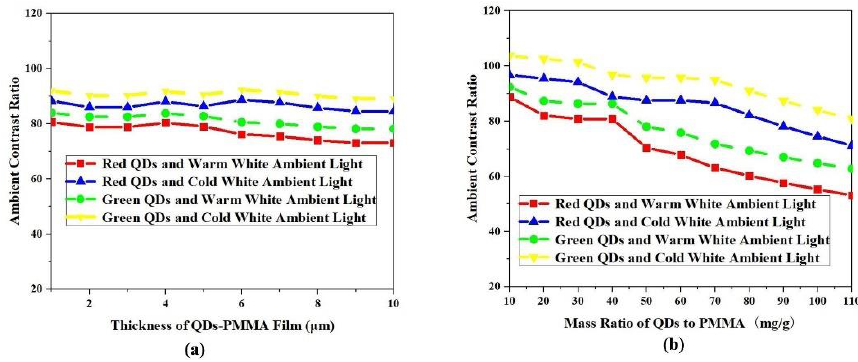
Figure 10. Simulated ACR for ( a ) different mass ratio of QDs to PMMA and ambient light; and ( b ) different thicknesses of QDs-PMMA matrix and ambient light.